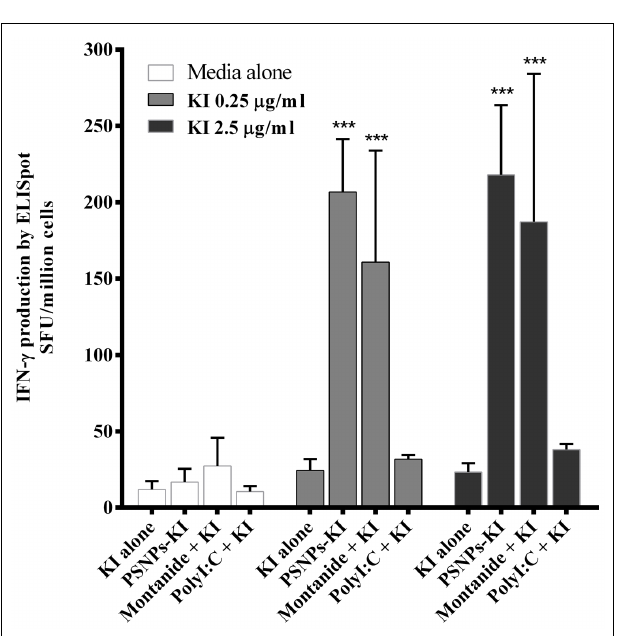
FIGURE 3 | Induction of SYIPSAEKI specific CD8T cells by different adjuvants. BALB/c mice were immunized twice, intradermally, 2 weeks apart, with SYIPSAEKI peptides incorporated with respective adjuvants. 14 days after the last immunization, spleen cells were collected and assessed for IFN- γ production by ELISpot assay. Data presented as mean ± SD of SFU/million cells from each group ( n = 3 mice/group). Statistical analysis was performed via ANOVA, *** p ≤